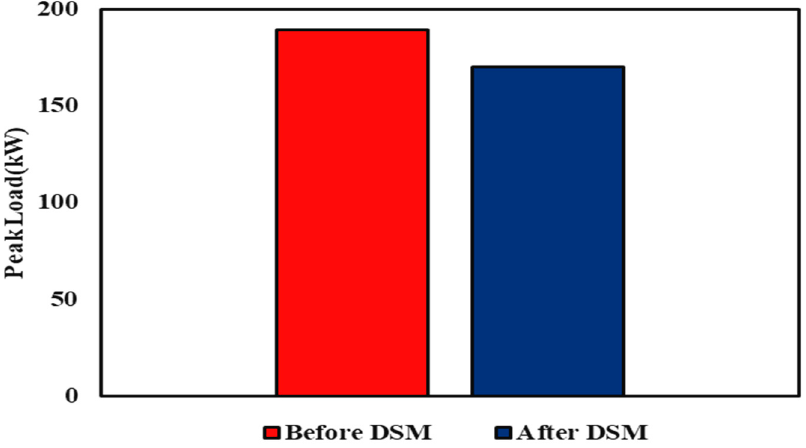
Figure 7. Monthly maximum demand reduction using Hybrid Optimization of Multiple Energy Resources (HOMER).